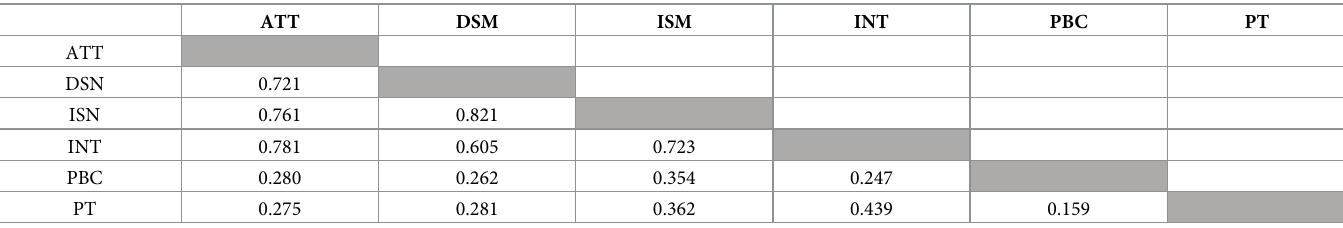
Table 5. The Heterotrait-Monotrait ratio of correlations (HTMT). ATT DSM